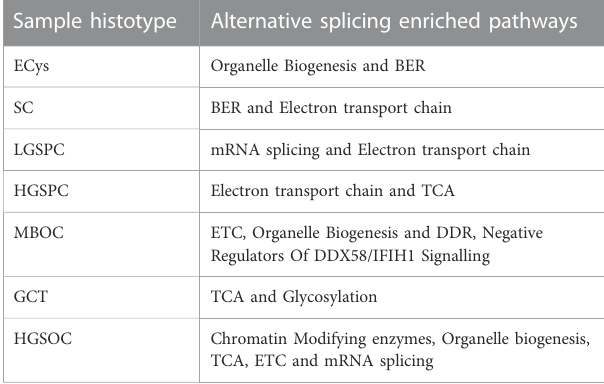
TABLE 9 Enriched pathways in alternative splice